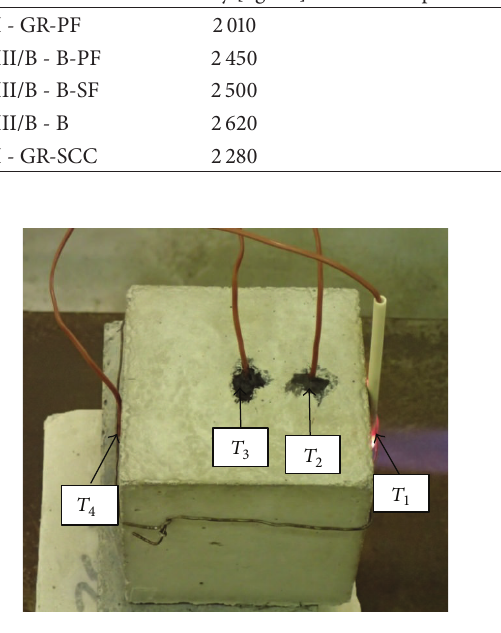
Figure 1: Location of individual